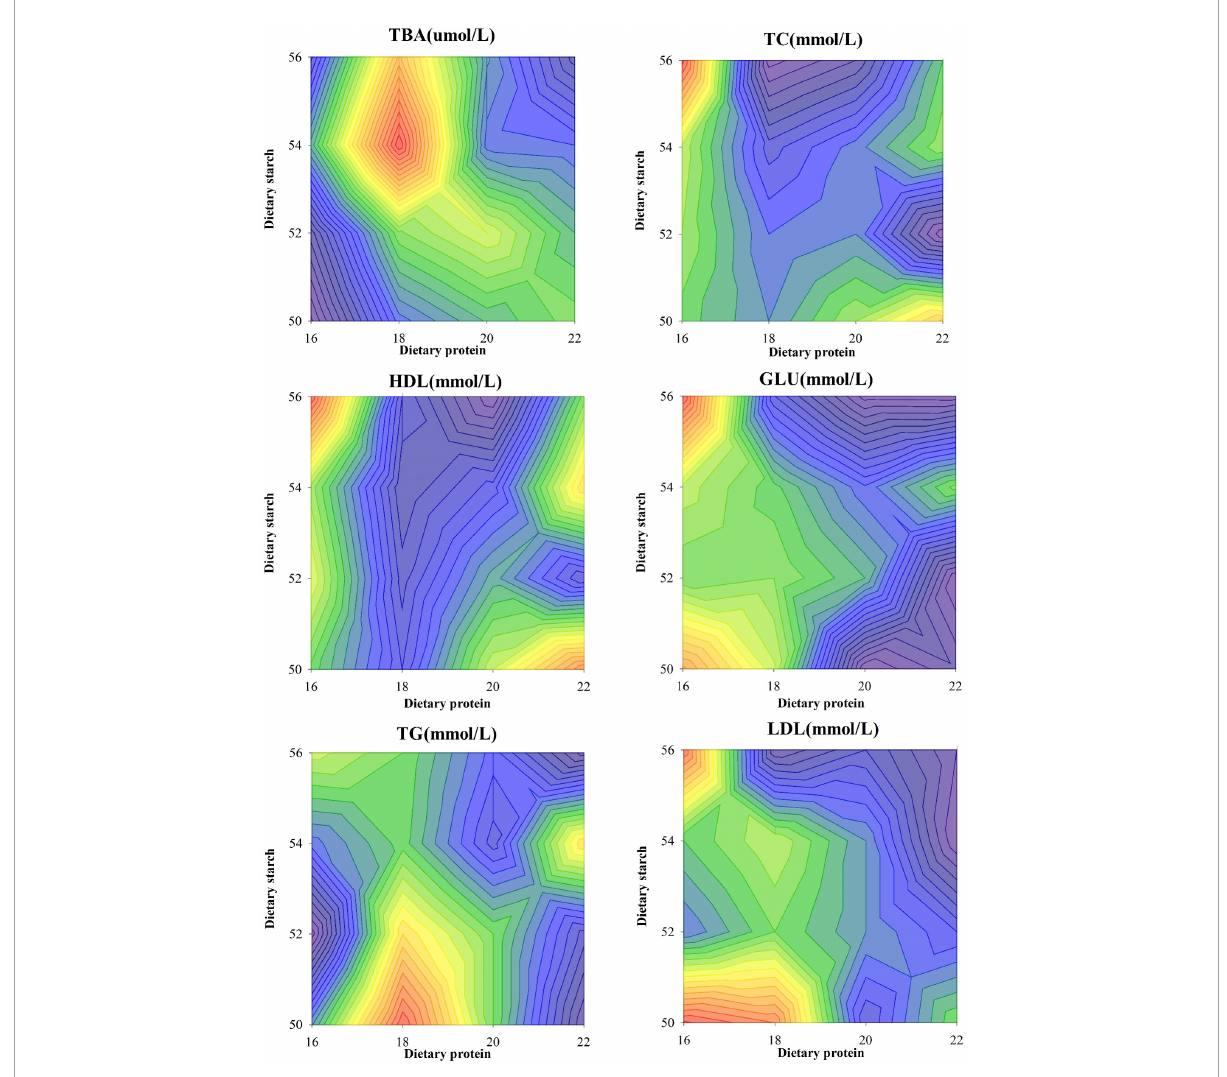
FIGURE2 Effects of different ratios of starch and protein in diet on serum lipid levels in mice. The value increases with the deepening of red and decreases with the deepening of blue.